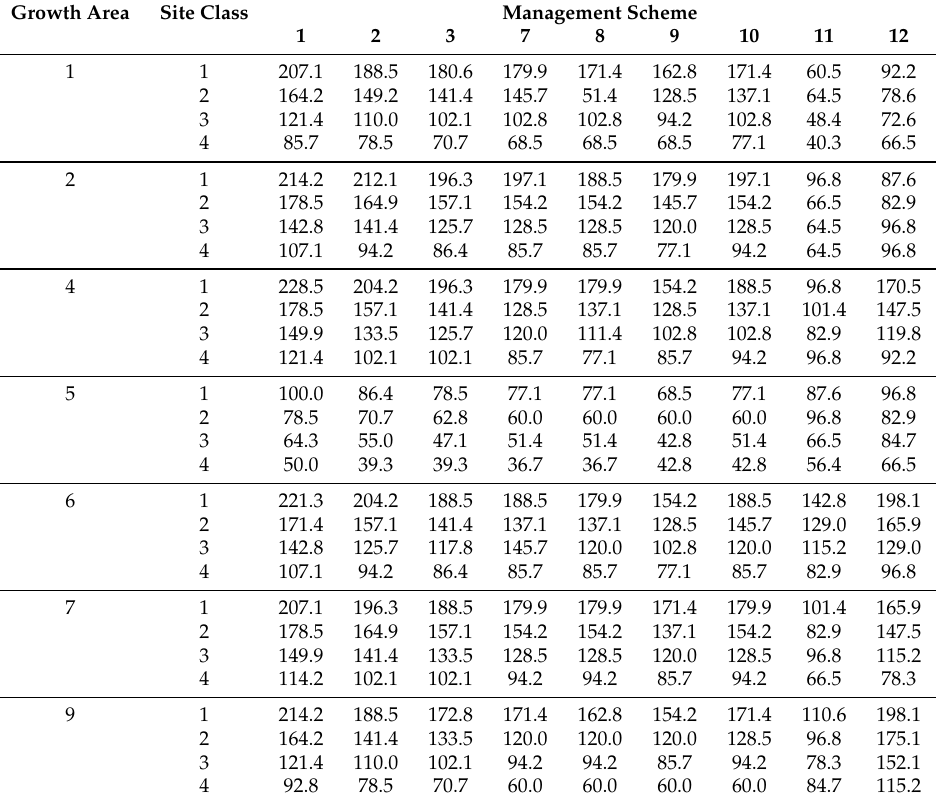
Table A2. Above-ground Biomass Carbon Pool for the different Growth Areas, Site Class and Management Scheme (1–10 for Pinus radiata , 11 Eucalyptus globulus and 12 Eucalyptus nitens ). Rotation length is 20 years for management scheme 1, 22 years for 2 and 3, 24 for 7 to 10, and 12 years for management scheme 11 and 12. Above-ground Biomass Carbon calculated using the methodology presented in Section 2.2 and data from [37].